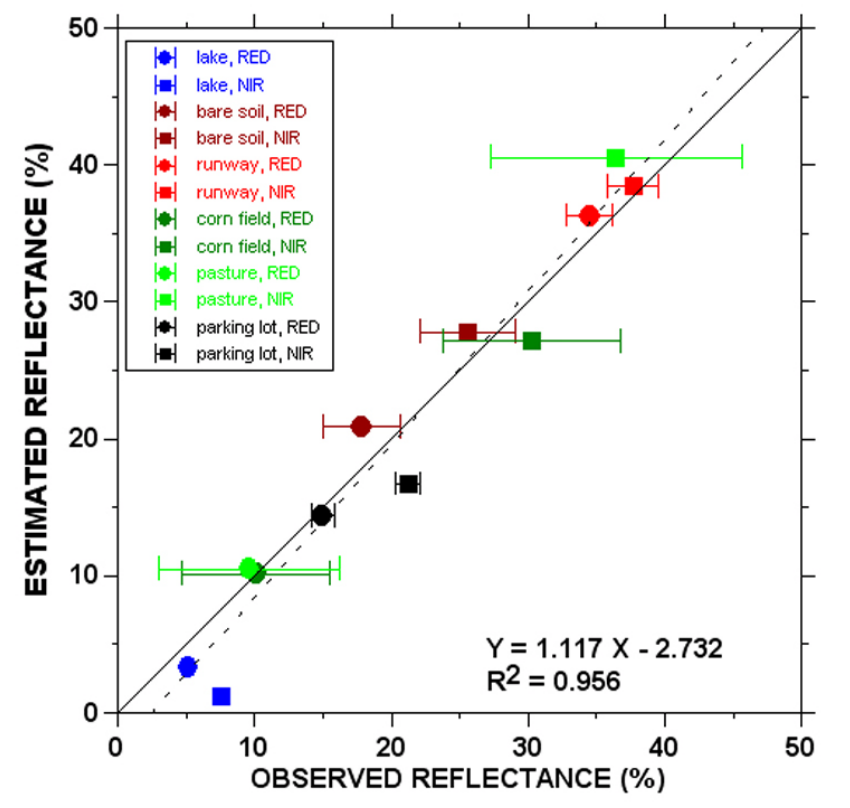
Figure 10. Observed values of surface reflectance in the NIR and red spectral bands for the six ground sites (see Table 3) plotted versus corresponding estimated values extracted from the May 13 and May 29 Landsat TM images following their conversion to reflectance. The solid diagonal line represents the 1:1 line, while the dashed line is the least-squares linear regression fit to the points. Error bars represent plus or minus one standard deviation about the mean of the observed